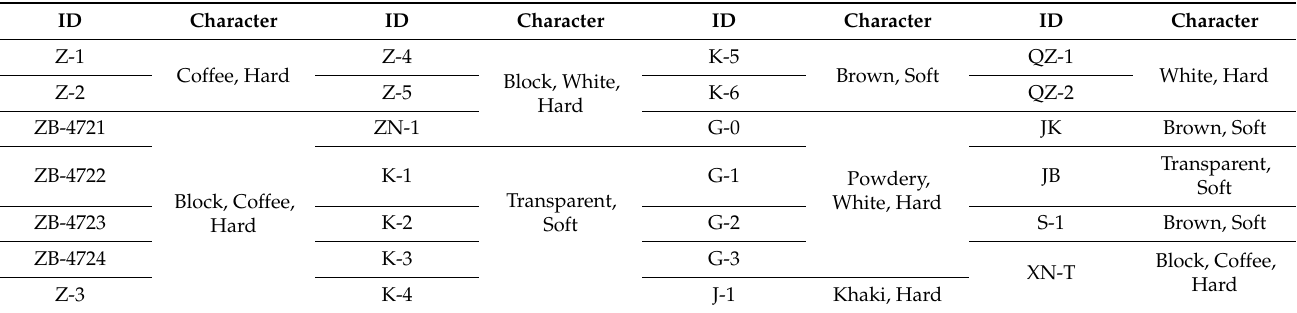
Table A1. A list of 27 kinds of swelling retarding particles.